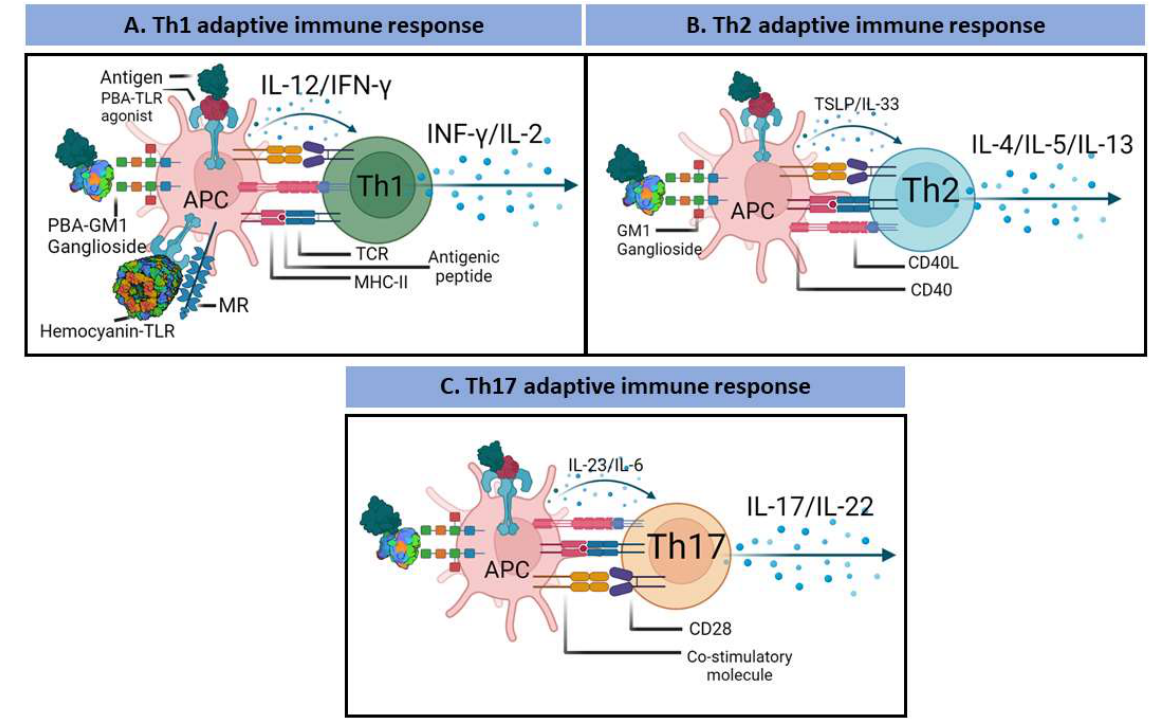
Figure 5. Mechanism of the adjuvant action of PBAs as vaccine immunomodulators. The PBAs can interact with APC. Through these interactions, PBAs trigger different mechanisms of the adaptive immune response, which facilitates the polarization of lymphocytes toward Th1-, Th2-, and Th17-cell phenotype acquisition, with subsequent release of their respective cytokines.